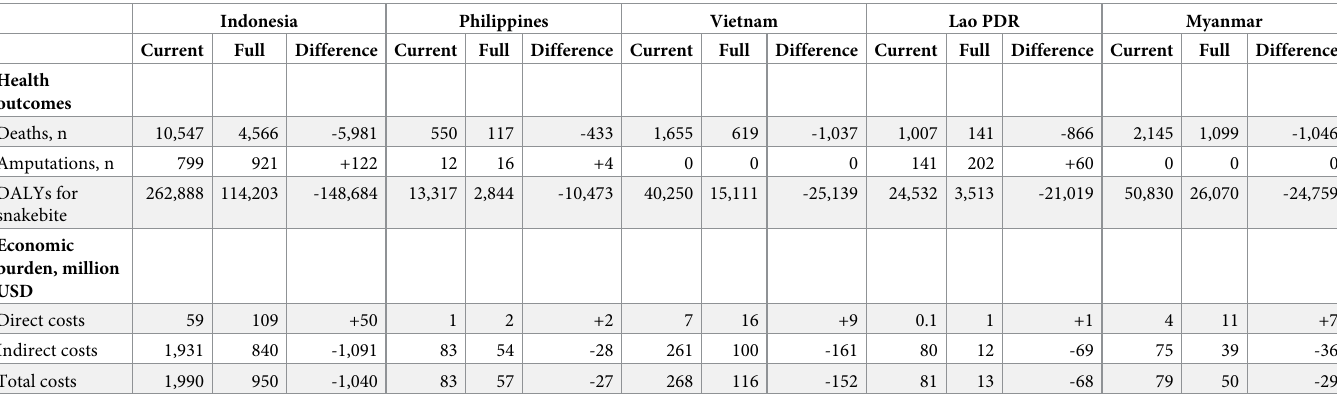
Table 1. Estimated economic and clinical impact of snakebite victims between current access and full access to snake antivenom in ASEAN